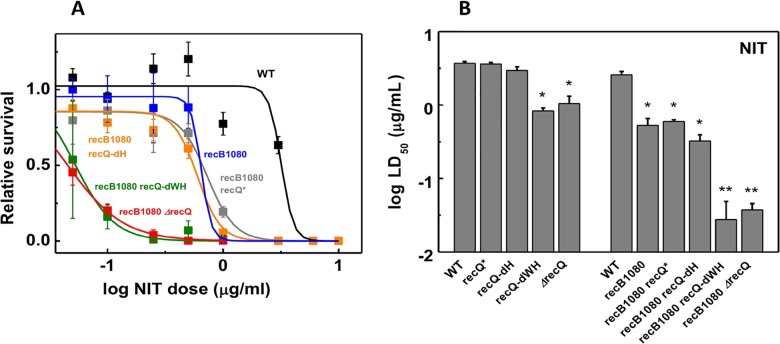
RecQ and RecB functional defects exert cumulative effects on the repair of nitrofurantoin-induced DNA damage.(A) Dose-dependent NIT survival of E. coli strains (means ± SE), fitted by a standard dose-response model (S2 Eq). Symbols for low survival values at high NIT doses (all measured up to 10 μg/mL) are mostly obscured by those of other strains with similar values. (B) Fitted log LD50 values of strains. Means ± SE of individual best-fits to biological replicates are shown. Asterisks indicate significant difference from the WT value (ANOVA, Tukey’s post-hoc test, p < 0.05). Double asterisks indicate further significant difference from values with single asterisk. Multiple WT controls are shown alongside mutant values determined in the same experimental run. Data for non-recB1080 strains are from ref. [15]. Sample sizes and determined parameters are listed in S3 Table.